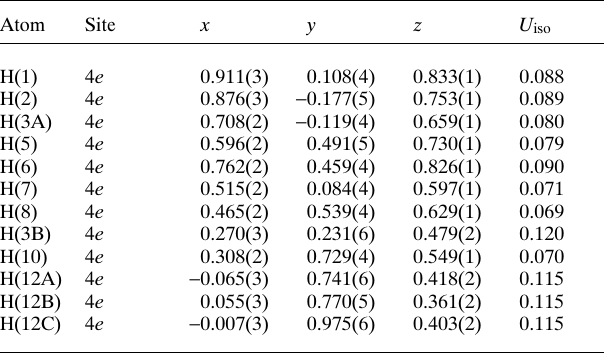
Table 2. Atomic coordinates and displacement parameters (in Å 2 )